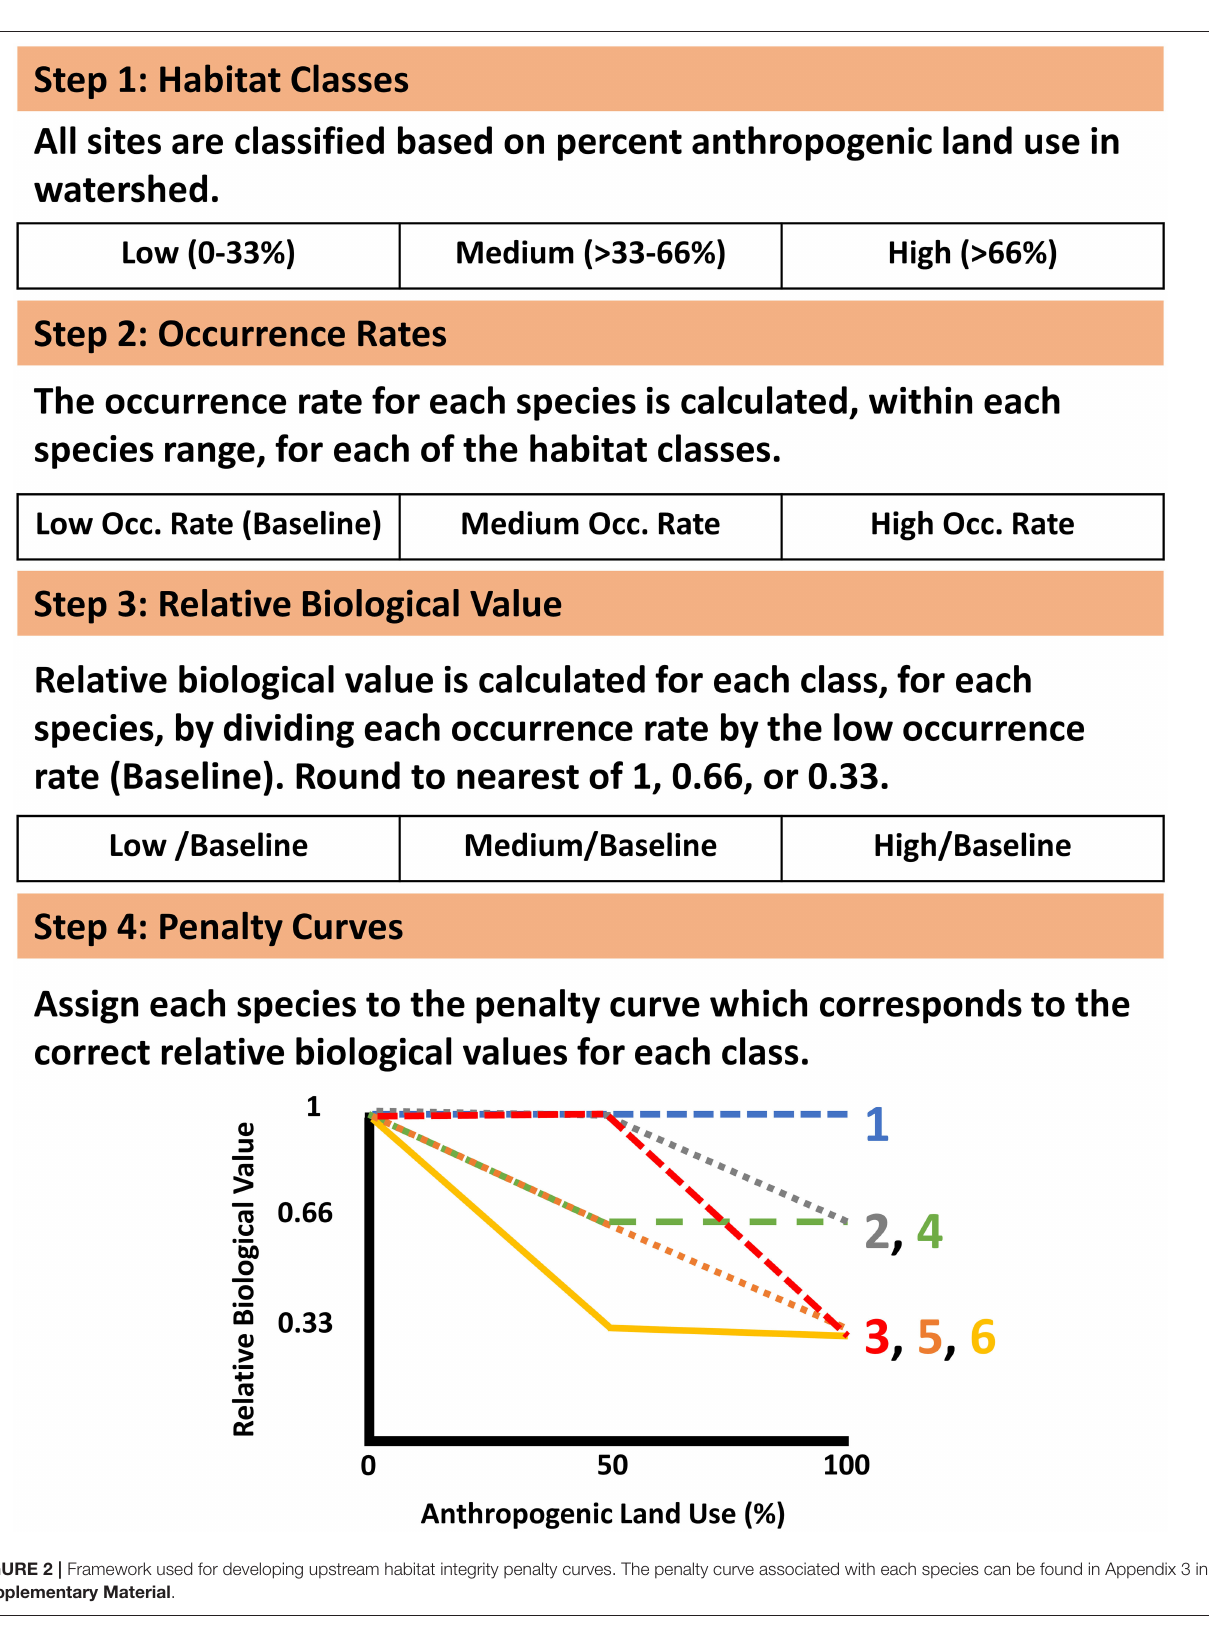
Frontiers in Environmental Science |